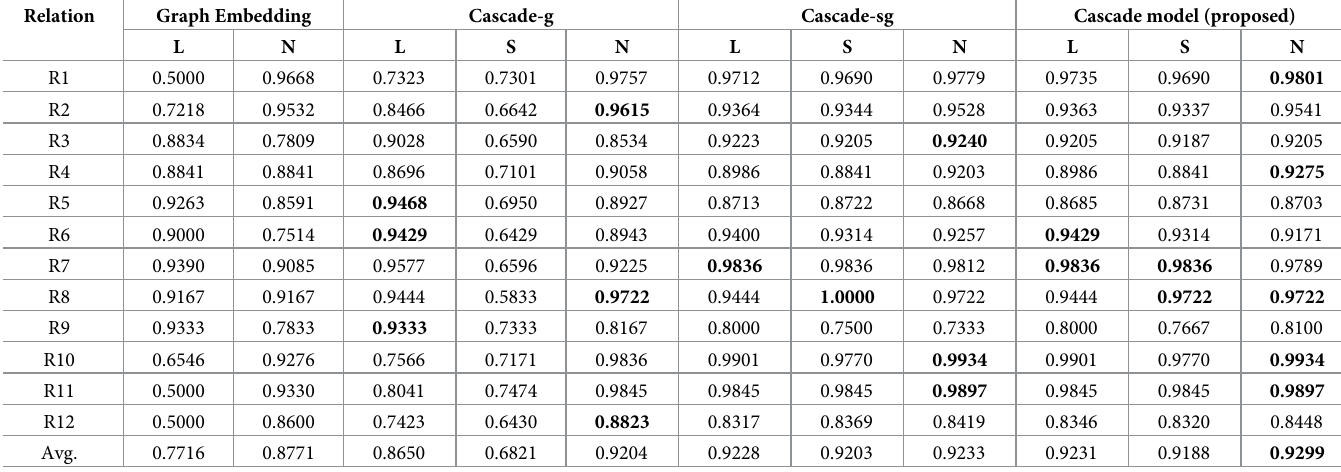
Table 3. Link Prediction based on settings of different graph embedding algorithms (accuracy).